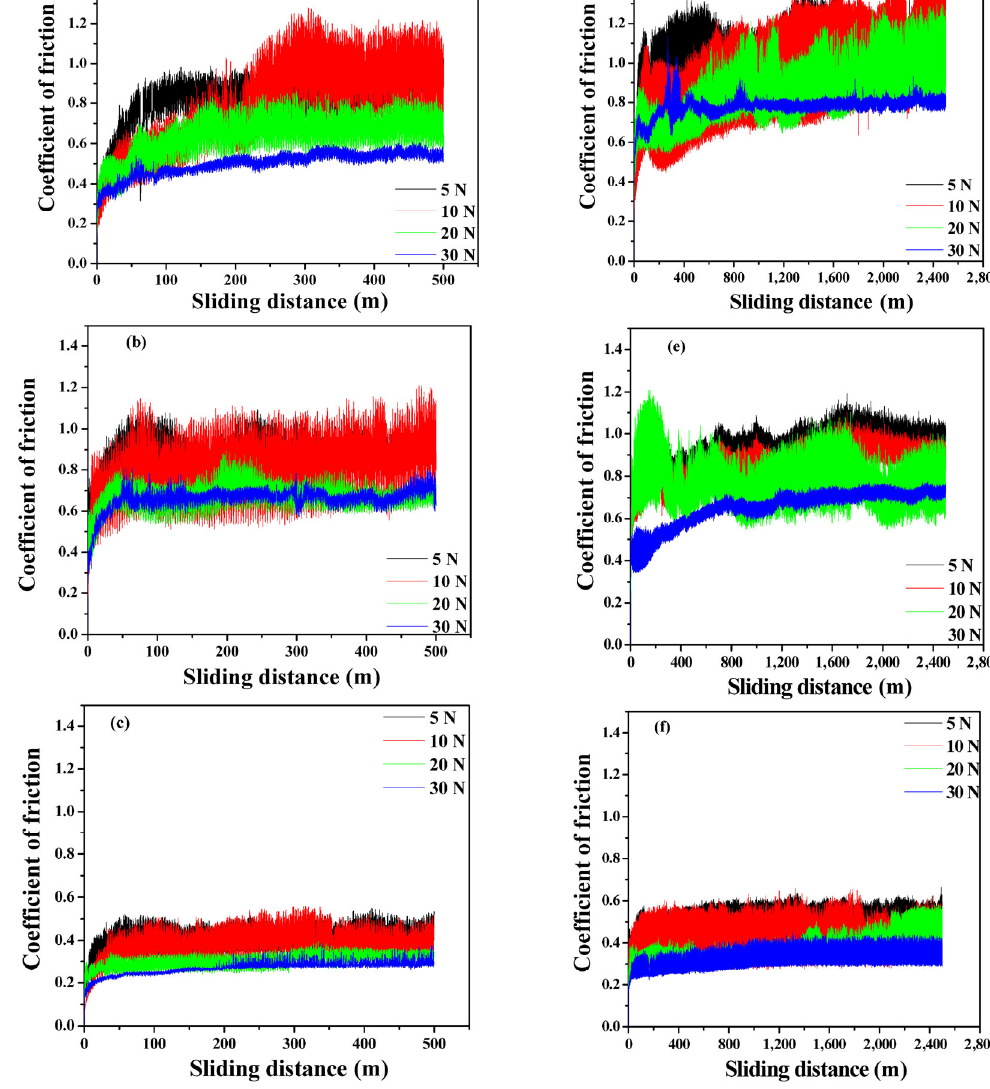
Fig. 8 Variation of COF under different applied loads and sliding distances of 500 m (a–c) and 2,500 m (d–f) of (a and d) cold compacted, (b and e) sintered, and (c and f) HPTed Cu-20%SiC